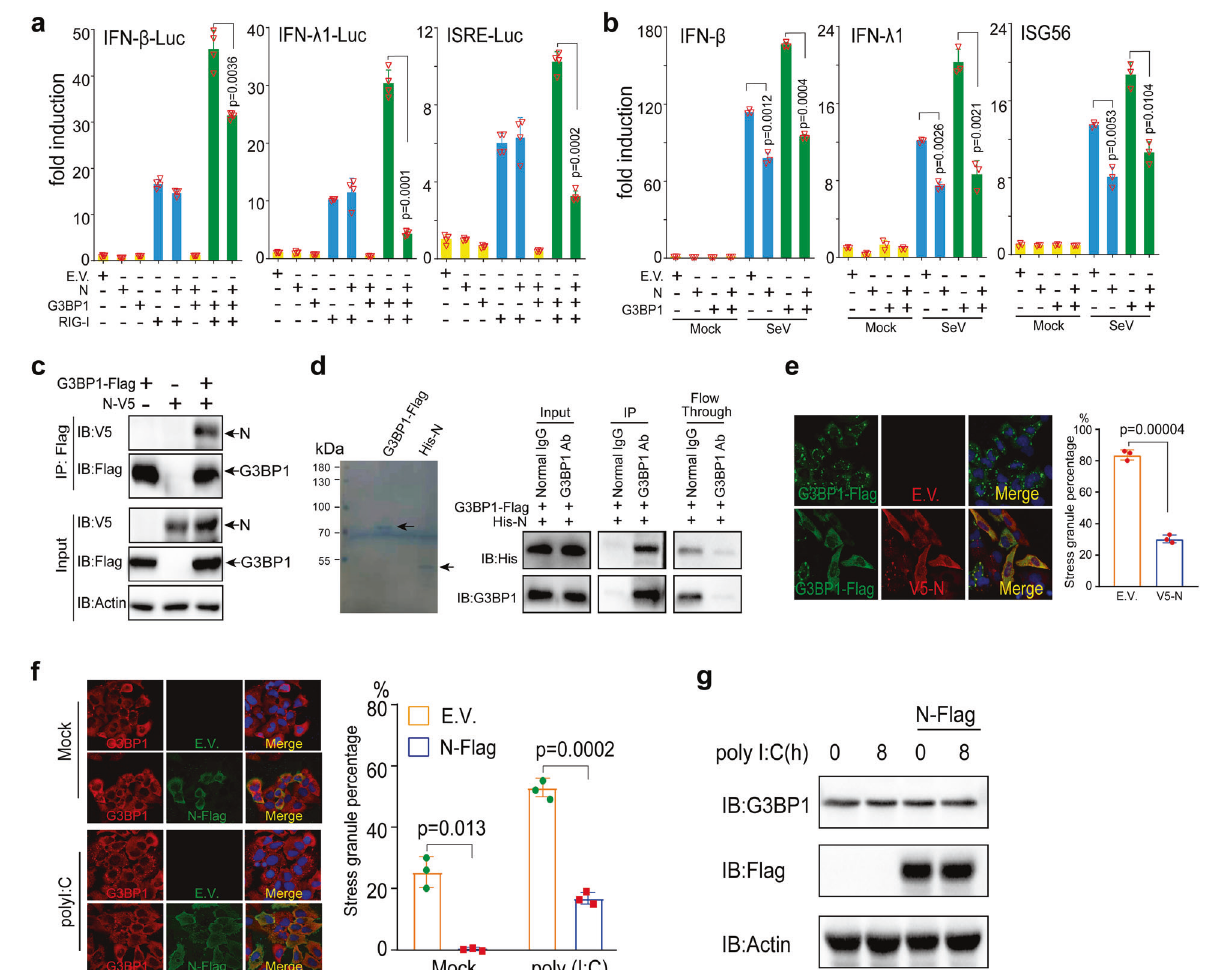
Fig. 5 N protein inhibits G3BP1-mediated RIG-I signaling activation by suppressing SG formation. a and b N protein inhibits G3BP1-mediated RIG-I signaling activation. Thirty-six hours after transfection into HEK293T cells with indicated plasmids, the luciferase activities were measured using dual-luciferase assays ( a ). Twenty-four hours after transfection, HEK293T cells were infected with SeV ( b ), and 6 h after infection, the cells were harvested to determine the induction of IFN- β , IFN- λ 1, and ISG56 using RT-qPCR. c and d N protein interacts with G3BP1. Co-IP analysis of the interaction between N-V5 and G3BP1-Flag in HEK293T cells ( c ). d Left panel: Coomassie blue staining analysis of the puri fi ed G3BP1-Flag and His-N proteins. Right panel: Co-IP analysis of the in vitro interaction between His-N and G3BP1-Flag. e N protein inhibits G3BP1-induced SG formation. Left panel: Confocal microscopic analysis of SG formation in HeLa cells transfected with G3BP1-Flag together with empty vector or expression vector of N for 24 h. Scale bars, 10 μ m. Right panel: Quanti fi cation analysis of the percentage of SG formation (50 cells per sample). f N protein inhibits poly (I:C)-induced SG formation. Left panel: Confocal microscopic analysis of SG formation in HeLa cells transfected with empty vector or expression vector of N for 24 h followed by stimulation with poly (I:C) for 0 or 8 h. Scale bars, 10 μ m. Right panel: Quanti fi cation analysis of the percentage of SG formation (200 cells per sample). g N protein does not affect G3BP1 expression. HeLa cells were transfected with plasmids as indicated, 16 h later, the cells were further stimulated with poly (I:C) by transfection. The expression of G3BP1, N-Flag, and actin was detected by immunoblotting. EV empty vector, h